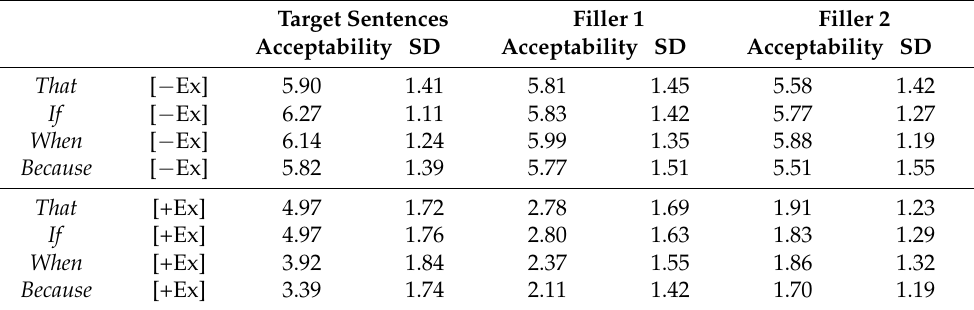
Table 2. Mean acceptability scores on a 7-point scale. [ ± Ex] = ± Extraction. Target Sentences Filler 1 Filler 2 Acceptability